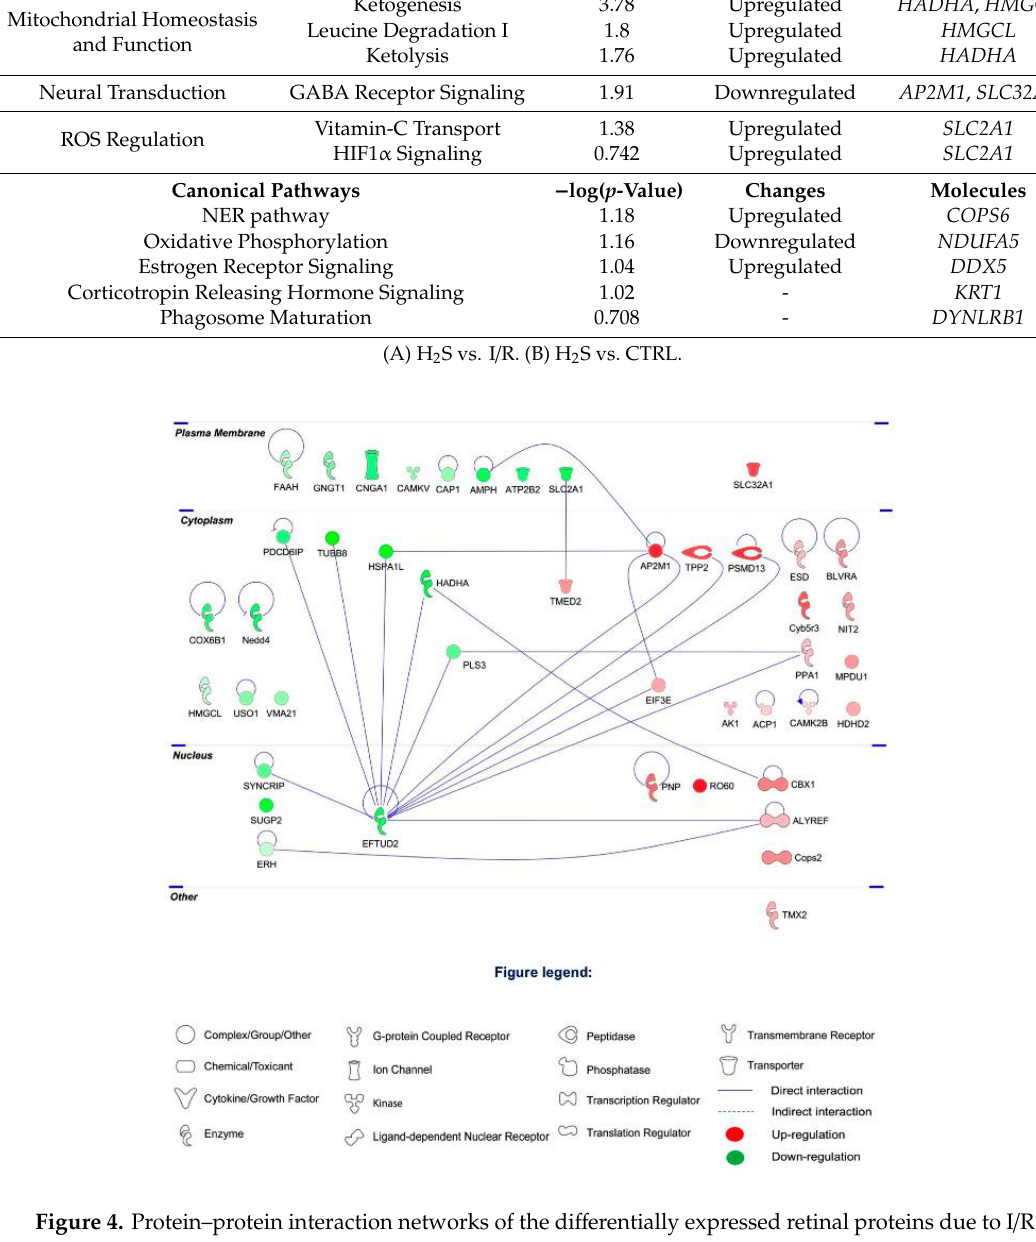
Figure 4. Protein – protein interaction networks of the differentially expressed retinal proteins due to Figure 4. Protein–protein interaction networks of the di ff erentially expressed retinal proteins due to I / R comparing to CTRL group. The major interaction networks of di ff erentially expressed retinal proteins I/R comparing to CTRL group. The major interaction networks of differentially expressed retinal obtained by IPA analysis (QIAGEN Inc., https: // www.qiagenbioinformatics.com / products / ingenuity- pathway-analysis) in I / R